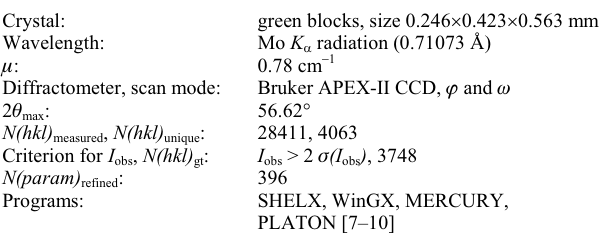
Table 1. Data collection and